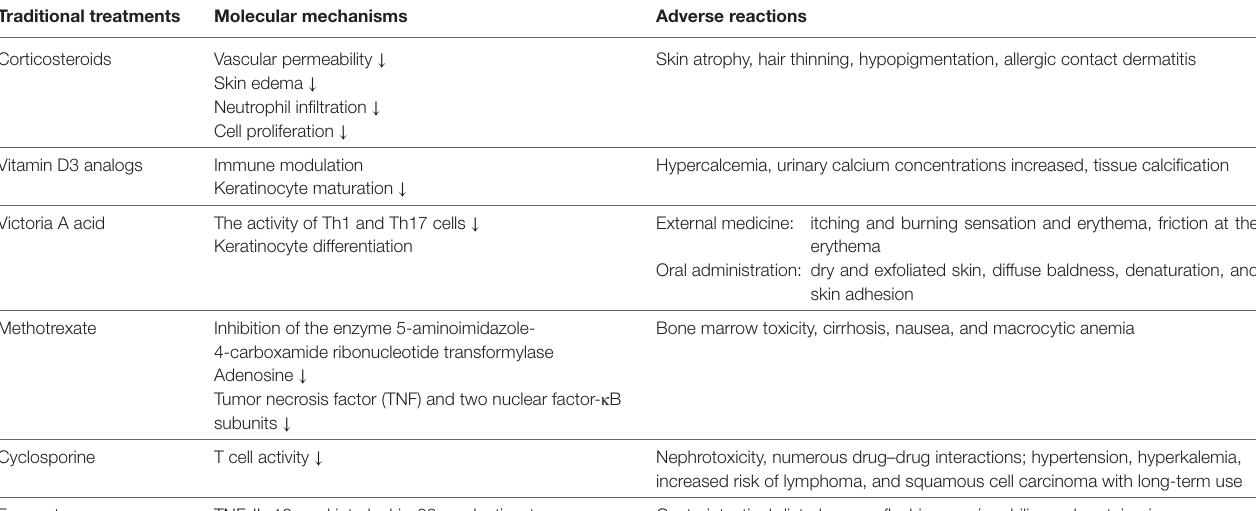
TAble 1 | Traditional treatment for